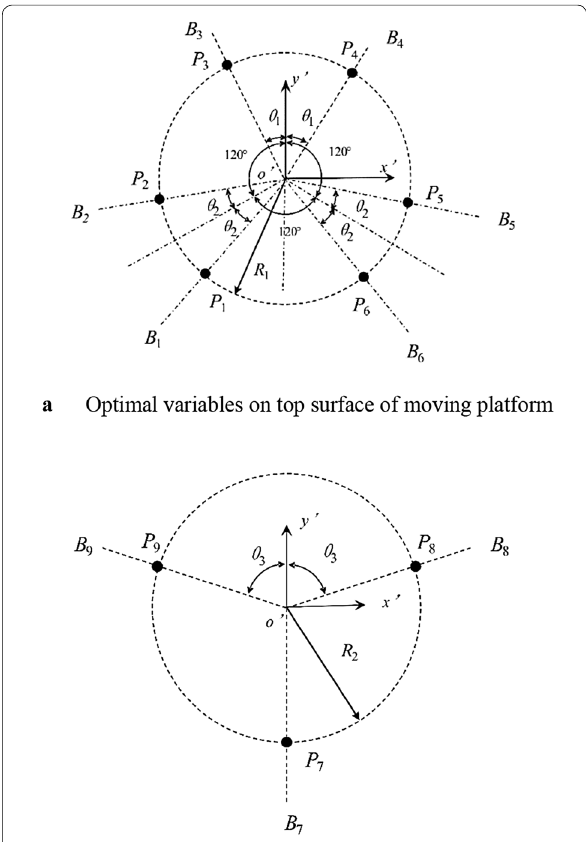
Figure 3 Optimal variables